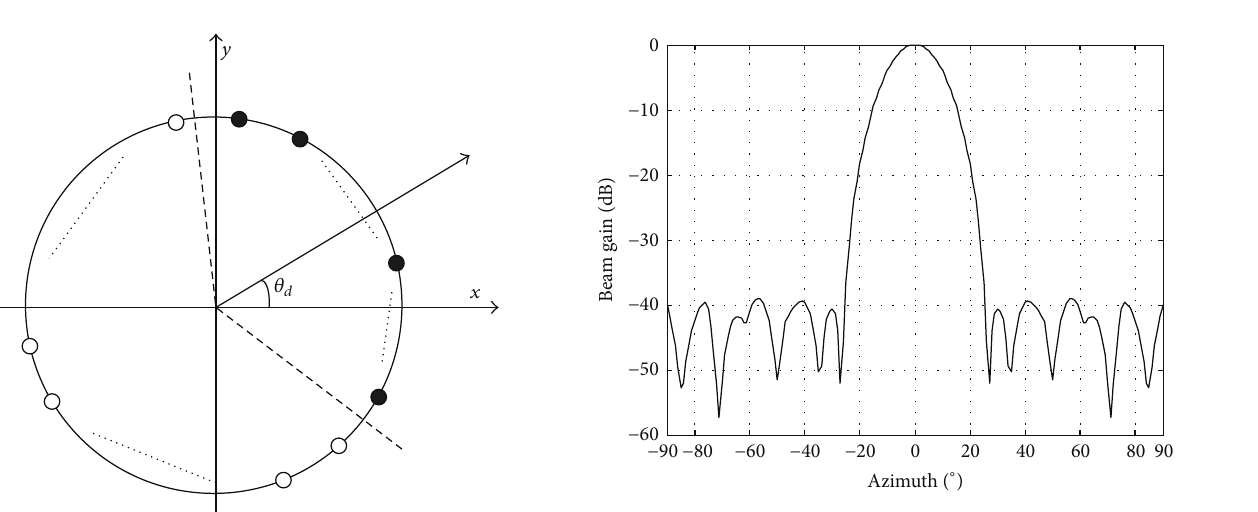
Figure 3: 1D beam pattern in the azimuth direction, with 𝜑 = 0 ∘ .